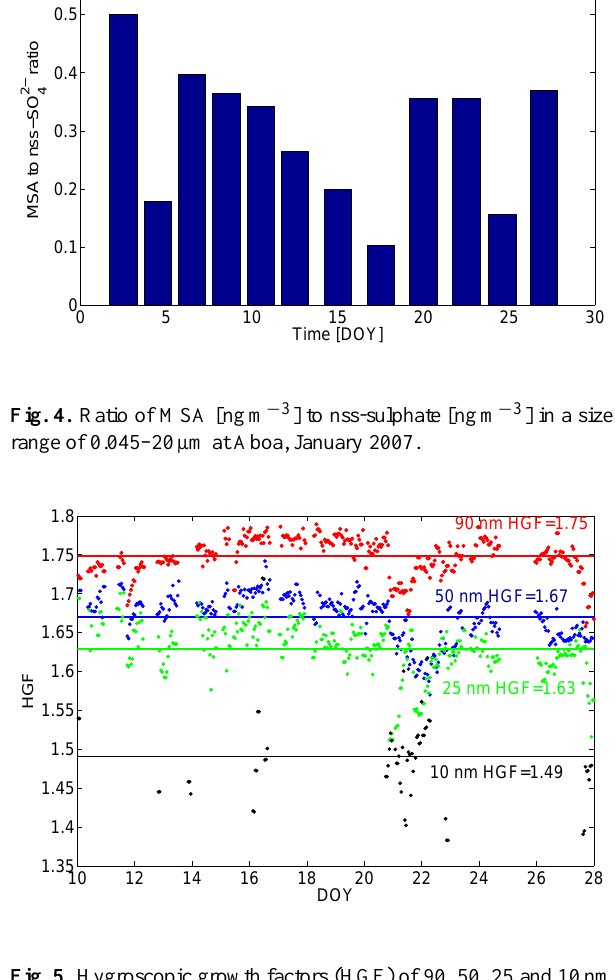
Fig. 5. Hygroscopic growth factors (HGF) of 90, 50, 25 and 10nm particles as a function of time presented in red, blue, green and black dots, respectively, measured in January 2007 at Aboa. The lines present the average HGF values during the measurement